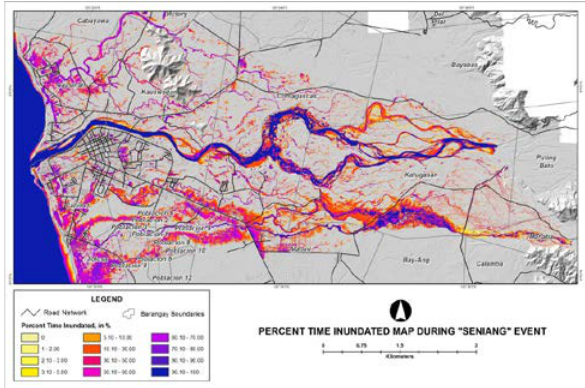
Figure 12. Map of percent time inundated for the Seniang